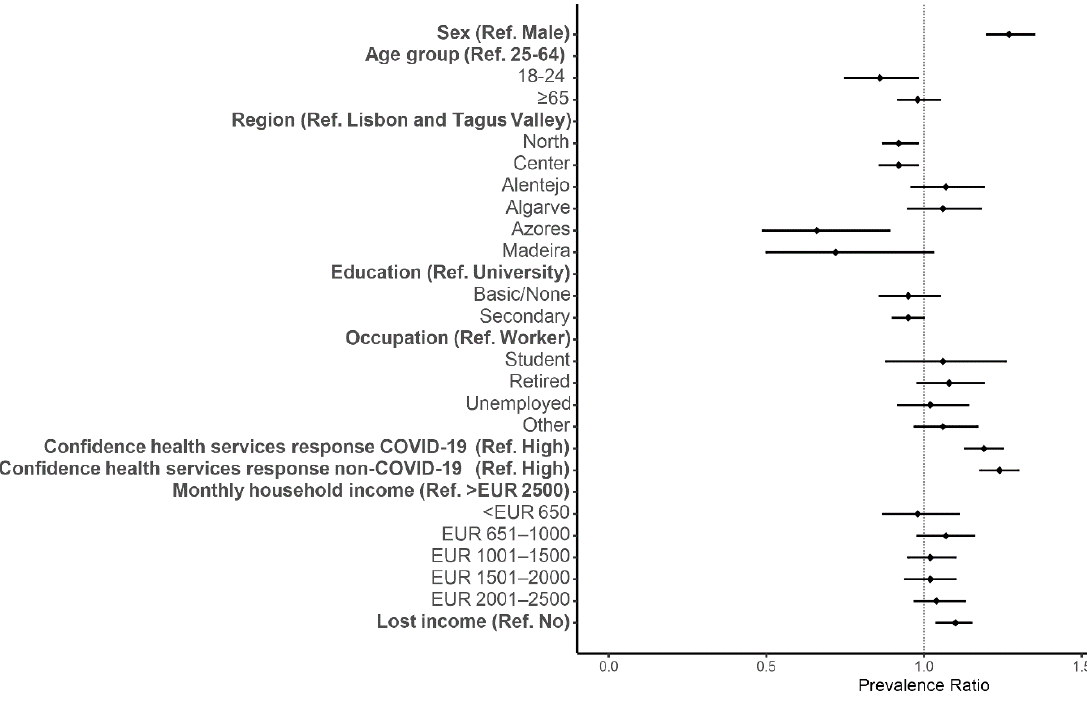
Figure 2. Forest plot of healthcare avoidance for predisposing and enabling factors. Adjusted prevalence ratio (adjusted for gender, age group, region, education, health perception and period of the questionnaire) and the respective 95% confidence intervals are denoted by black dots and black lines, respectively.